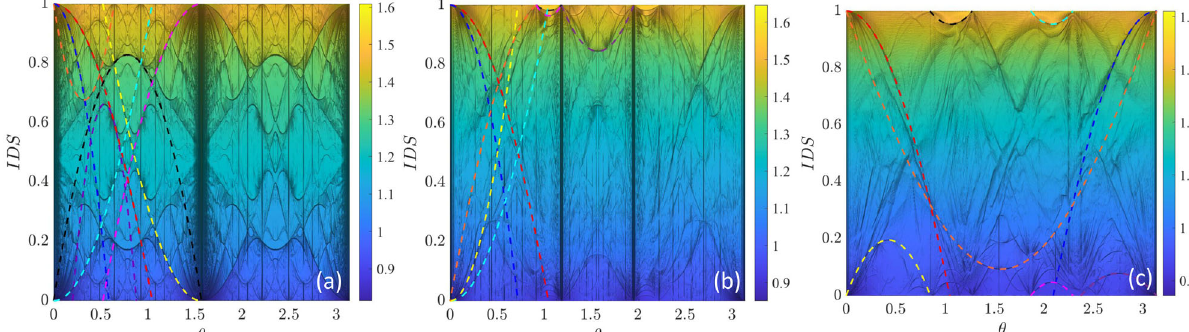
Fig. 6 Integrated density of states fi tting for gap labeling. Integrated density of states (color maps) as a function of twist angle θ for lattices with ( a ) a 1 = a = 1 and β = π /2, ( b ) a 2 lines with colors corresponding to different spectral gaps, illustrating excellent